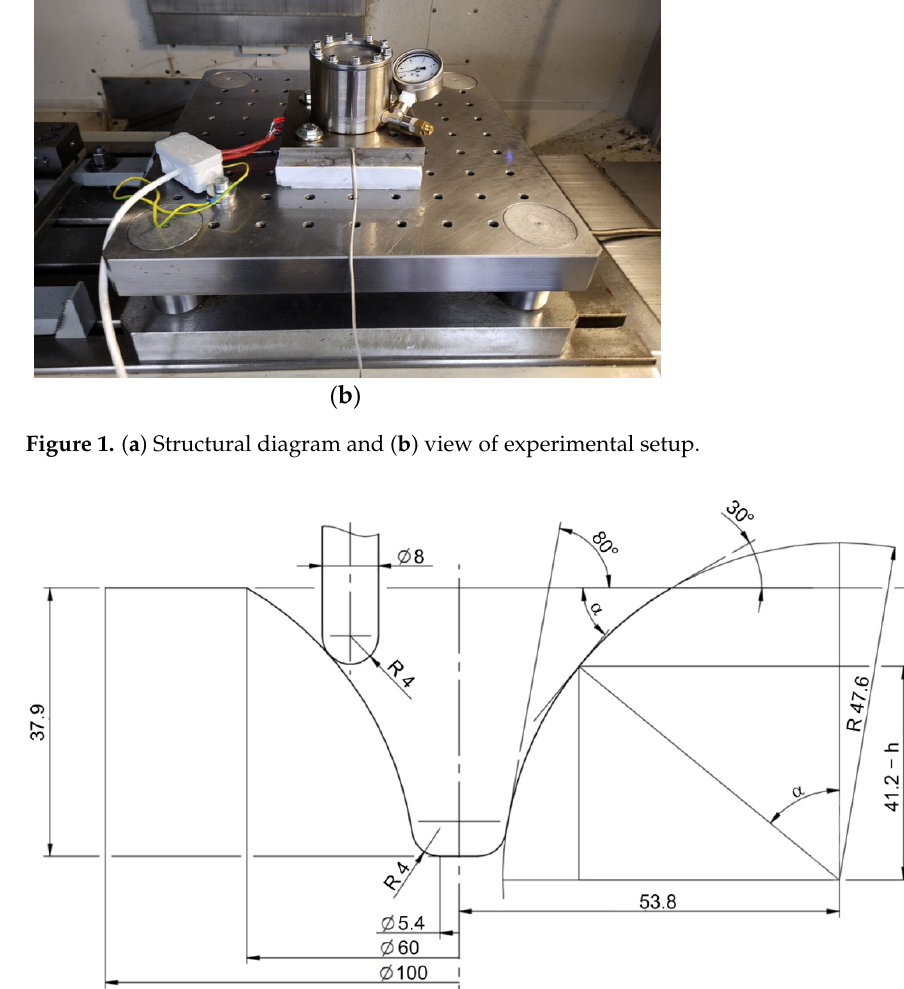
Figure 2. Geometry and dimensions of varying wall angle conical frustums (dimensions in mm).